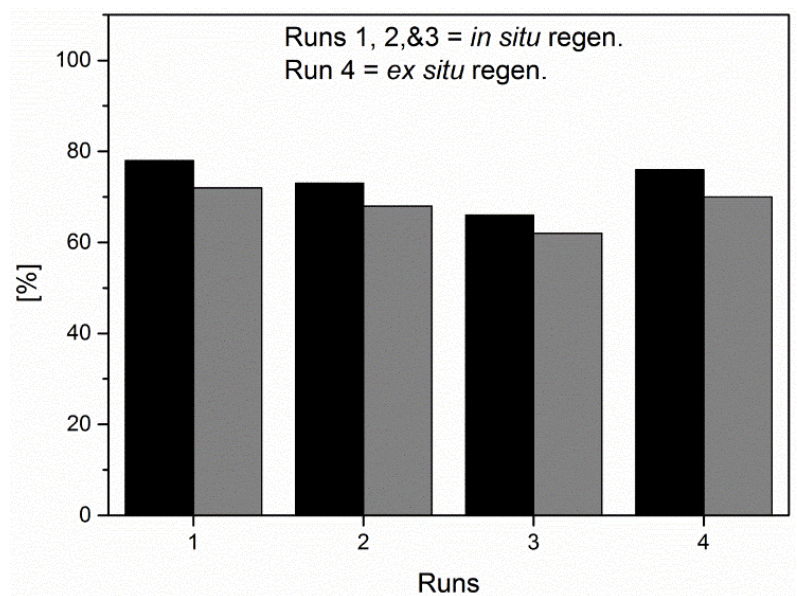
Figure 7. DME conversion (black) and MA yield (grey) in DME carbonylation with 1 wt% Cu- RHM-18 upon reuse with in situ (run 1–3) and ex situ (run 4) regeneration, respectively. Reaction conditions: 500 mg catalyst, 220 °C, 100 mL min − 1 gas flow of DME/CO/N 2 = 1.3/93.7/5.0%, 2 h, 7 bar, GHSV = 6711 h − 1 . Data reported with an estimated error corresponding to ± 2%.